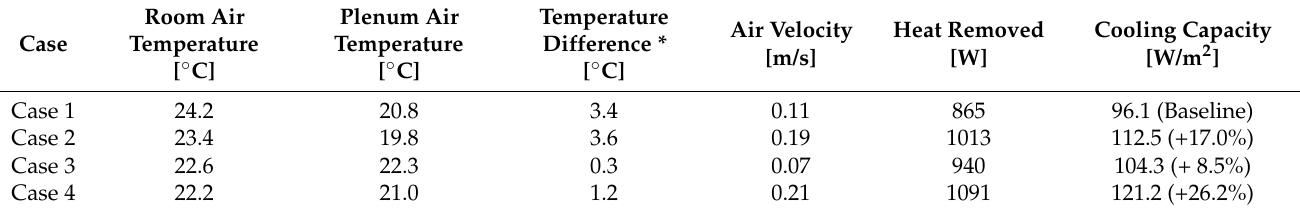
Table 3. Evaluation results of cooling capacity.